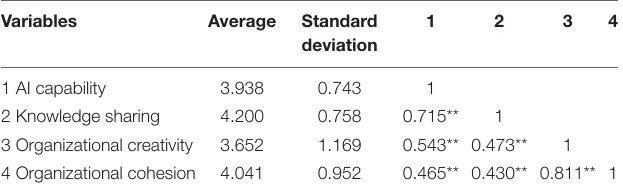
TABLE 2 | Descriptive statistics results with correlation coefficients.